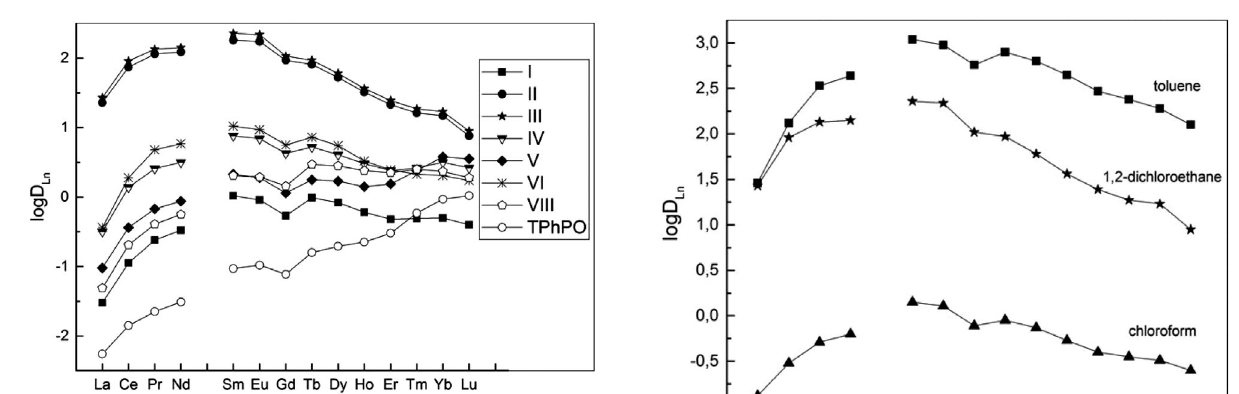
Turanov et al.: Synergistic Solvent Extraction of Lanthanides(III) ...